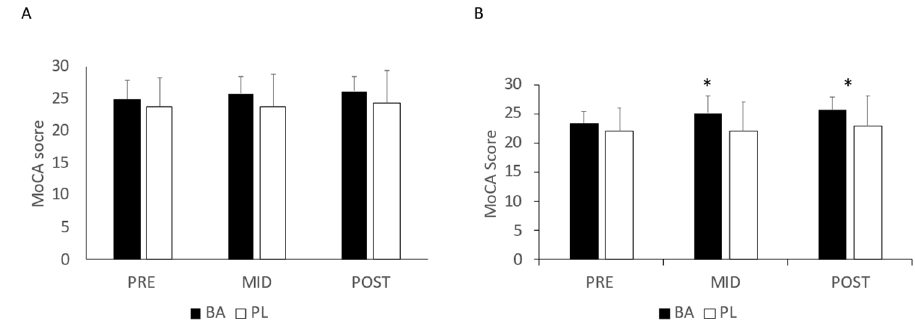
Figure 2. MoCA scores. ( A ) all participants; ( B ) Only participants with a MoCA score ≤ 26; * = Significant difference between groups. BA = β -alanine; PL = Placebo.All results are presented as mean ± SD.